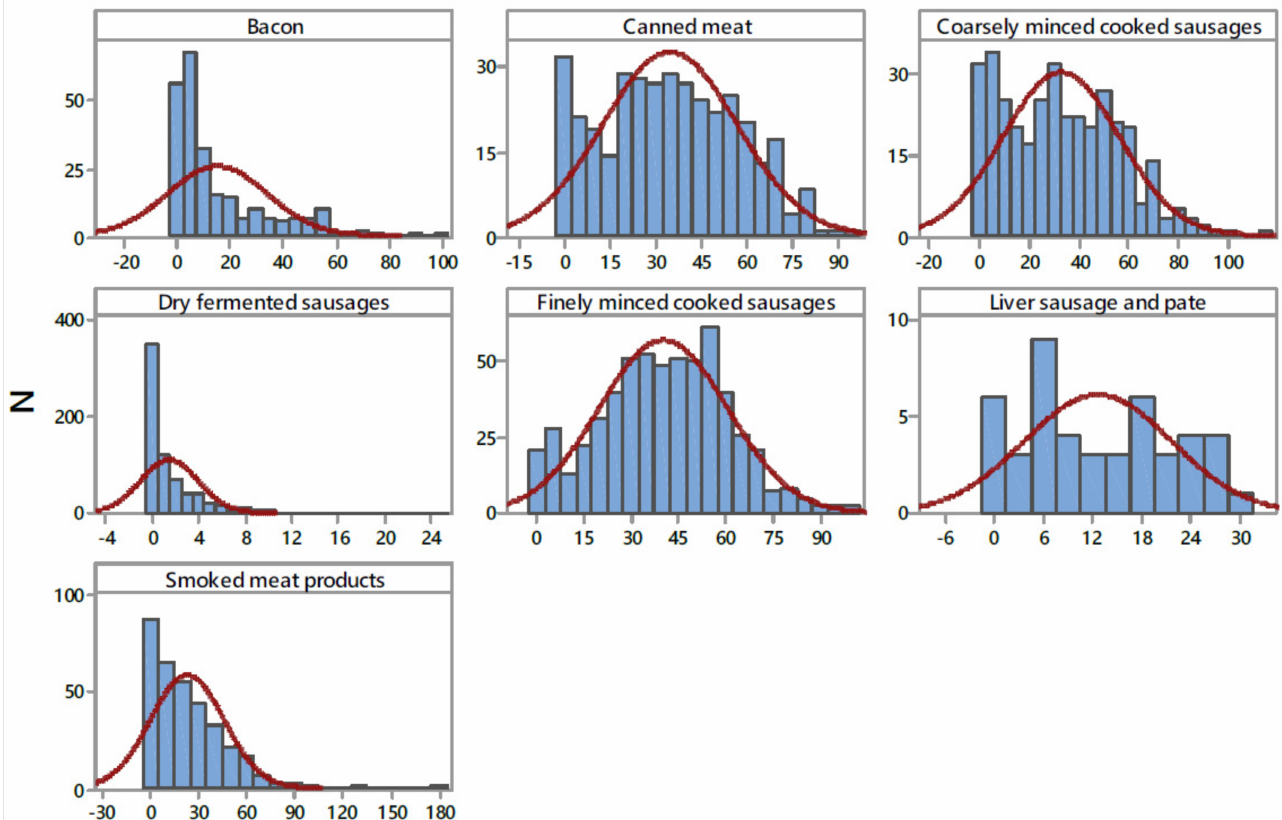
Figure 2. Distribution of NaNO 2 content in examined processed meat products (mg kg − 1 ). N—number of